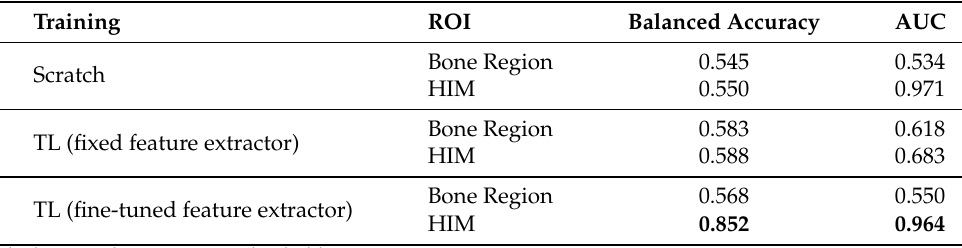
TL (fine-tuned feature extractor)